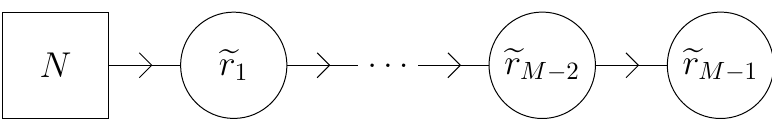
Figure 12 . The quiver which is dual to the one in (cid:12)gure